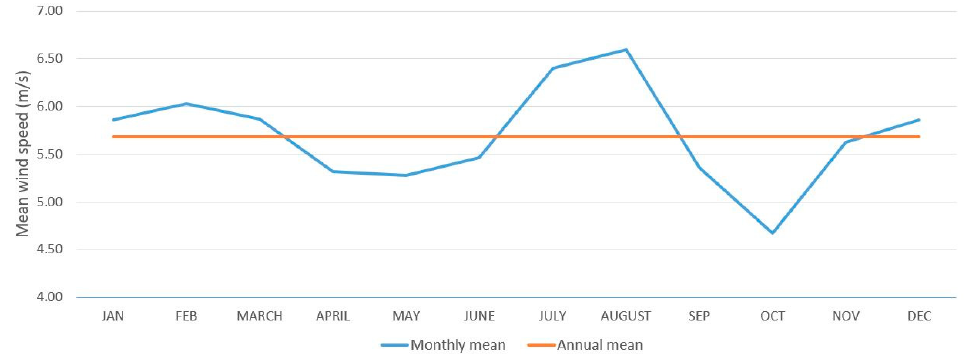
Figure 4. Average values of the wind records taken by the buoy over the year (2009–2020 period).